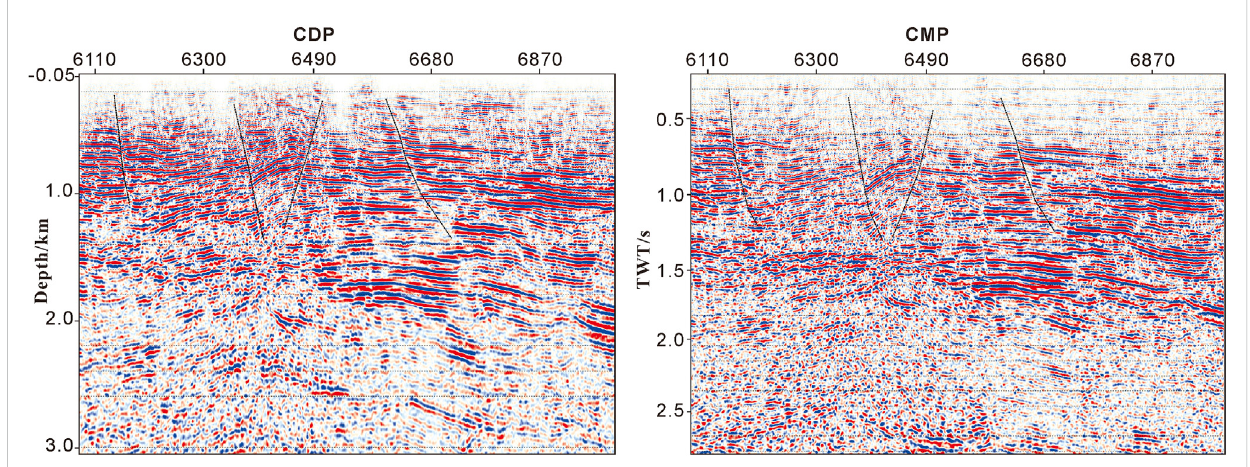
FIGURE 8 Localenlargedpro fi lecomparisonofthesecondaryfaultsintheuppercrustofthePSDMpro fi le(left)andPSTMpro fi le(right).(Theenlargedrangeis marked in Figure 7).